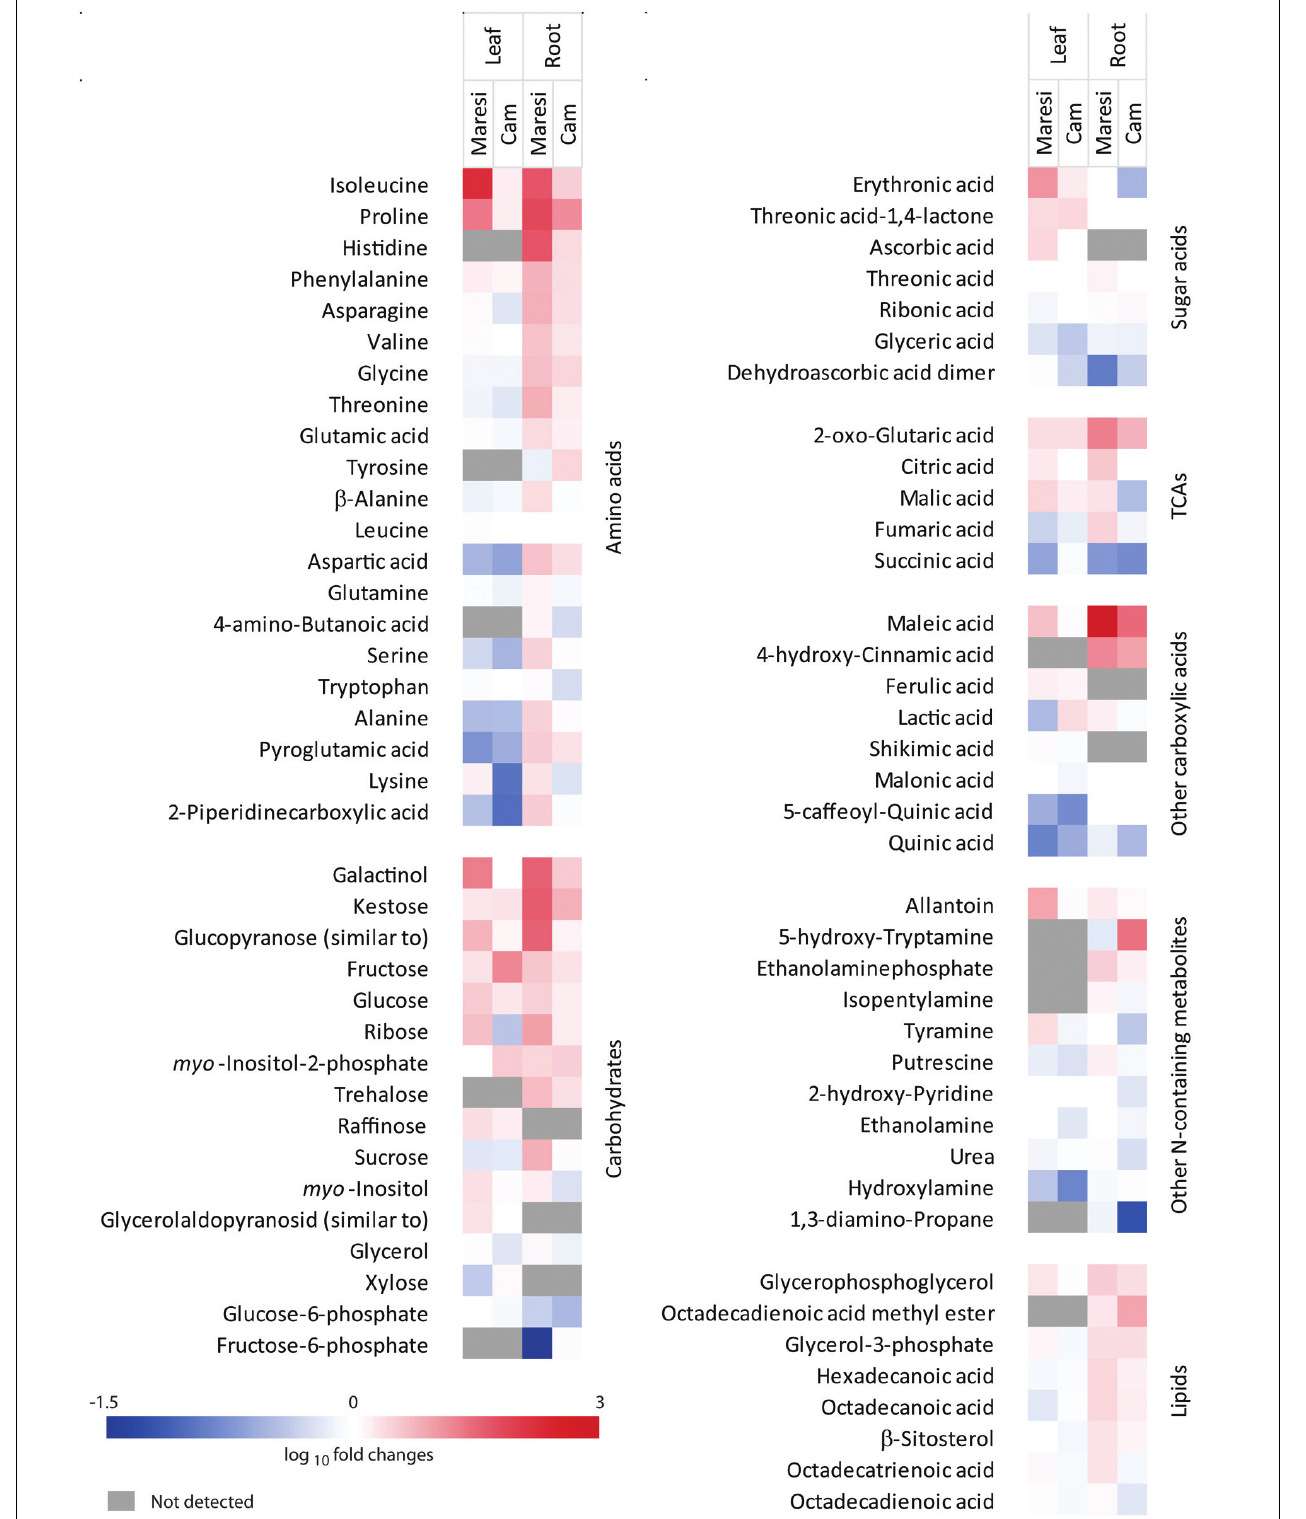
FIGURE 6 | Drought-induced changes in the accumulation levels of metabolites identified in both tested barley lines. Quantitative results and statistical significance are shown in Supplementary Table S1.